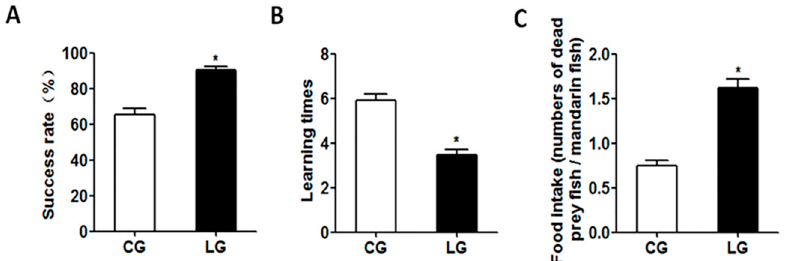
Figure 1. The success rate ( A ), learning times ( B ) and food intake ( C ) of mandarin fish (CG) with the negative demonstration fish (wild mandarin fish without training) and fish (LG) with the positive demonstration fish (pre-trained mandarin fish which could accept dead prey fish). Data are represented as mean ± S.E.M. ( n = 12). A value followed by * differs significantly from all other values not followed by the same superscript at the same time point based on a one-way analysis of variance (ANOVA) followed by the post hoc test ( * p < 0.05).